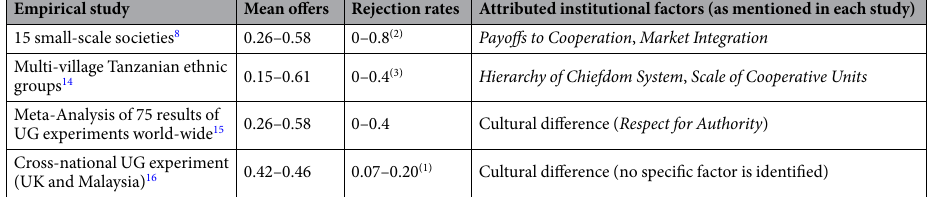
Table 1. Empirical studies of variation of fairness norms using the Ultimatum Game and attributed social/ institutional factors. Mean offers are reported for different treatments and social groups. Offer values are scaled between 0 and 1. (1) rejections as a proportion of all responses. (2) Rejection rates for offers of 0.2 or less. (3) Rejection rates for offers of 0.1 (i.e., 100 Tanzanian